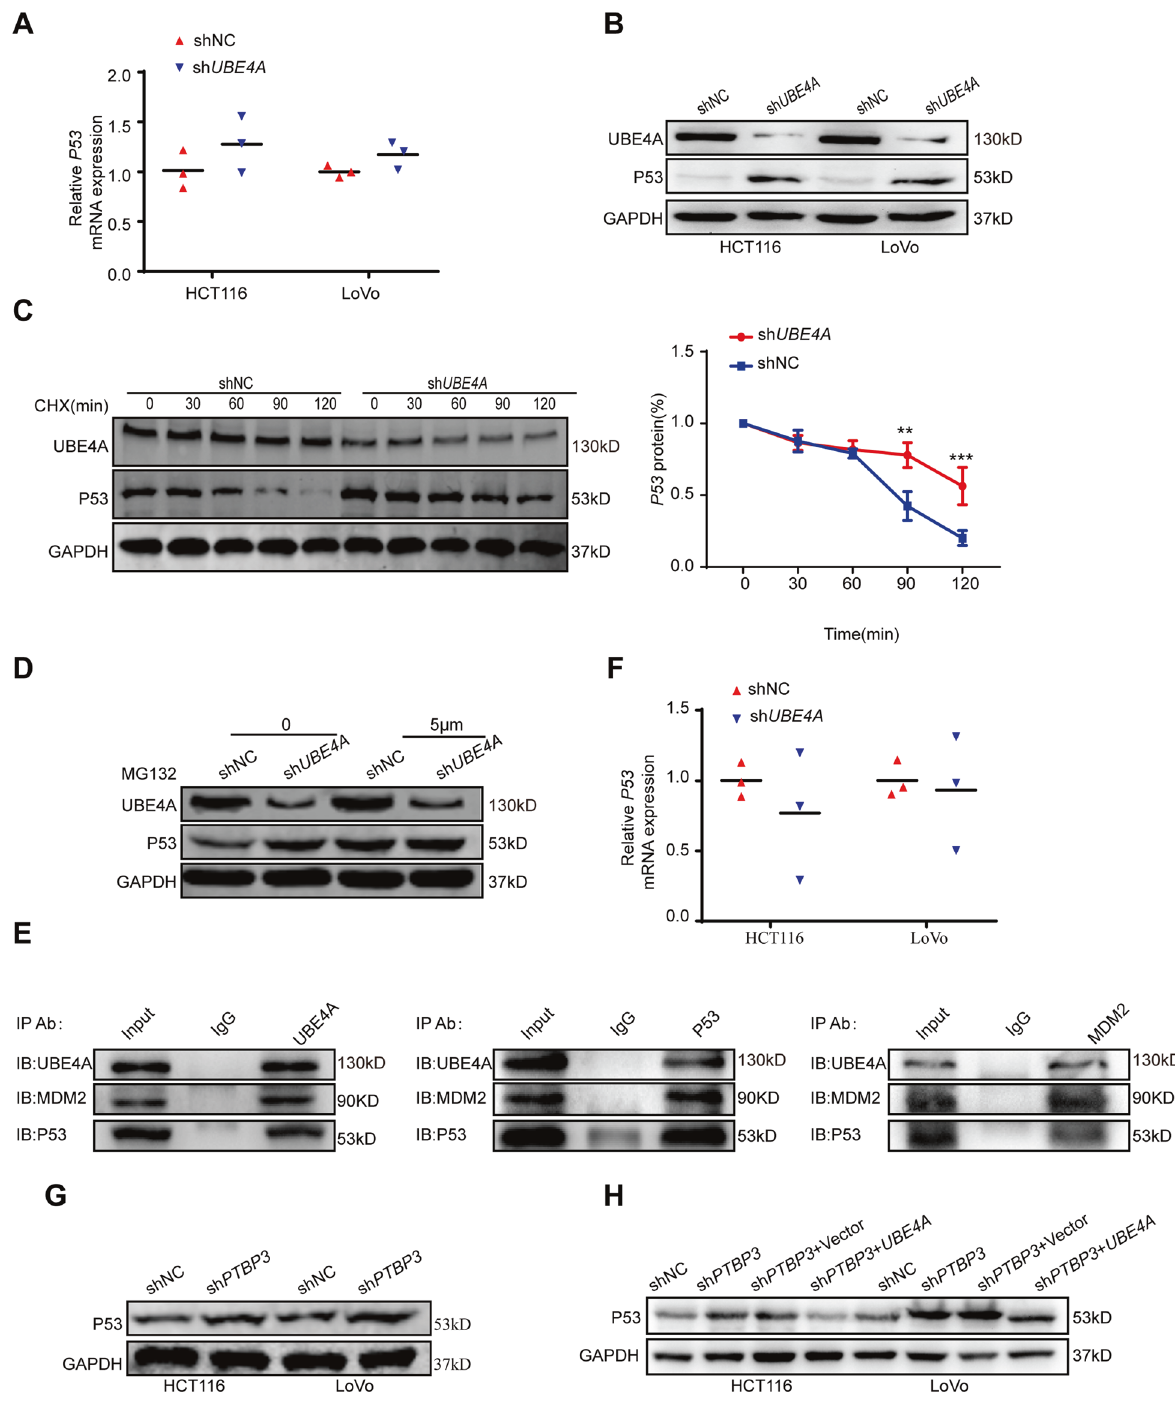
Fig. 5 PTBP3 regulates P53 expression by UBE4A ubiquitin degradation. A Relative mRNA expression level of P53 in UBE4A -silenced HCT116 and LoVo cells compared with that of control (NC) cells (measured by qRT-PCR; GAPDH was used as an internal control) (two-tailed Student ’ s t -test, P > 0.05). B Relative protein level of P53 in UBE4A -silenced HCT116 and LoVo cells compared with that of control (NC) cells (measured by Western blotting). C sh UBE4A and shNC HCT116 cells were treated with 100 μ g/mL of cycloheximide (CHX) and harvested at the indicated time points. P53 protein was detected by western blotting (left), quanti fi ed by densitometry, and plotted against time to determine P53 stability (right) (two-tailed Student ’ s t -test, P < 0.05). D sh UBE4A and shNC HCT116 cells were treated with 5 μ mol/L of MG132 for 12 h, and P53 protein was detected by western blotting. E Immunoprecipitation assays showing that UBE4A 、 MDM2 and P53 three proteins bound to each other. F Relative mRNA expression level of P53 in PTBP3 -silenced HCT116 and LoVo cells compared with that of control (NC) cells (measured by qRT- PCR; GAPDH was used as an internal control) (two-tailed Student ’ s t -test, P > 0.05). G Relative protein level of P53 in PTBP3 -silenced HCT116 and LoVo cells (measured by Western blotting). H PTBP3 knockdown HCT116 and LoVo cells were transfected with the UBE4A plasmid, and P53 expression was detected. (measured by Western blotting). The results are presented as means ± s.d. and are representative of at least three independent experiments.